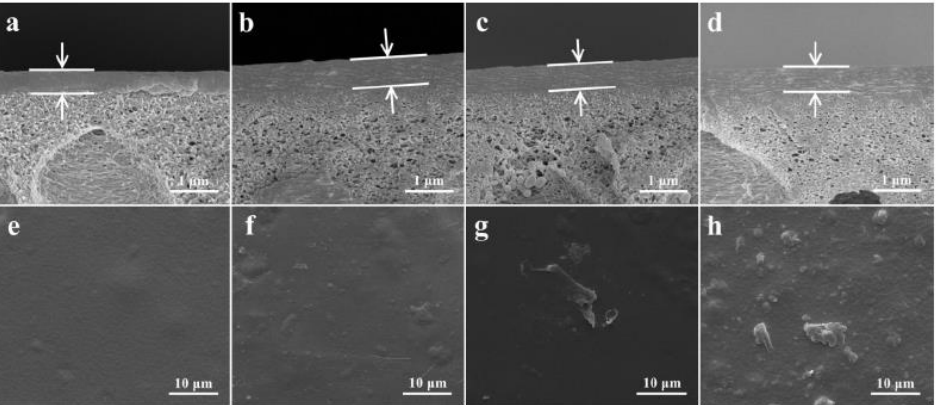
Figure 6. SEM cross-section images of ( a ) pure NaAlg on PAN substrate; ( b ) ( c ) and ( d ) MMMs containing g-C 3 N 4 content 2, 3 and 5 wt% with respect to NaAlg. ( e ) to ( h ) Corresponding surface images of ( a ) to ( d ), respectively. Reproduced with permission from [51], published by Elsevier, 2015.